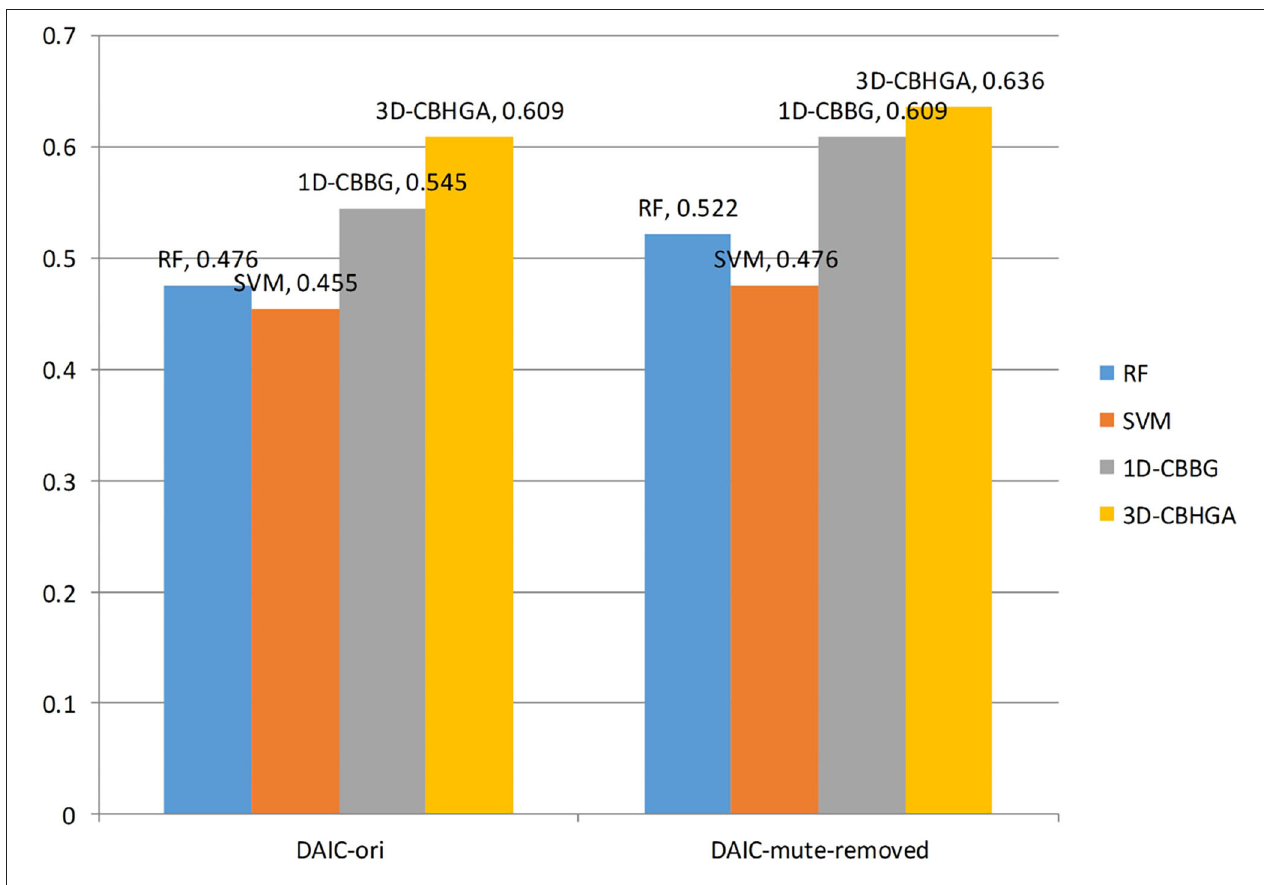
FIGURE 12 | F1 values of different